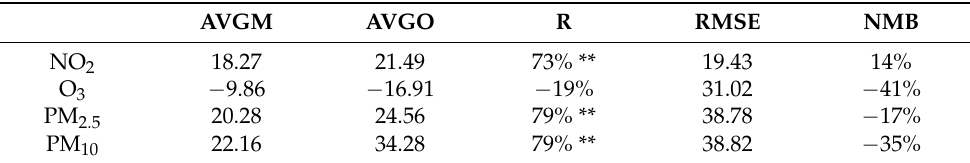
RMSE is the root mean square error between the differences in observed and modeled daily mean concentra- tions; NMB is the normalized mean deviation between the differences in observed and modeled daily mean concentrations; ** indicates significant correlation at 0.01 level Table 6. Statistics comparing the di ff erences in observed and modeled daily mean concentrations ( μ g/m (cid:2871) ) of NO 2 , O 3 , PM 2.5 and PM 10 during the NP and LP. AVGM AVGO R